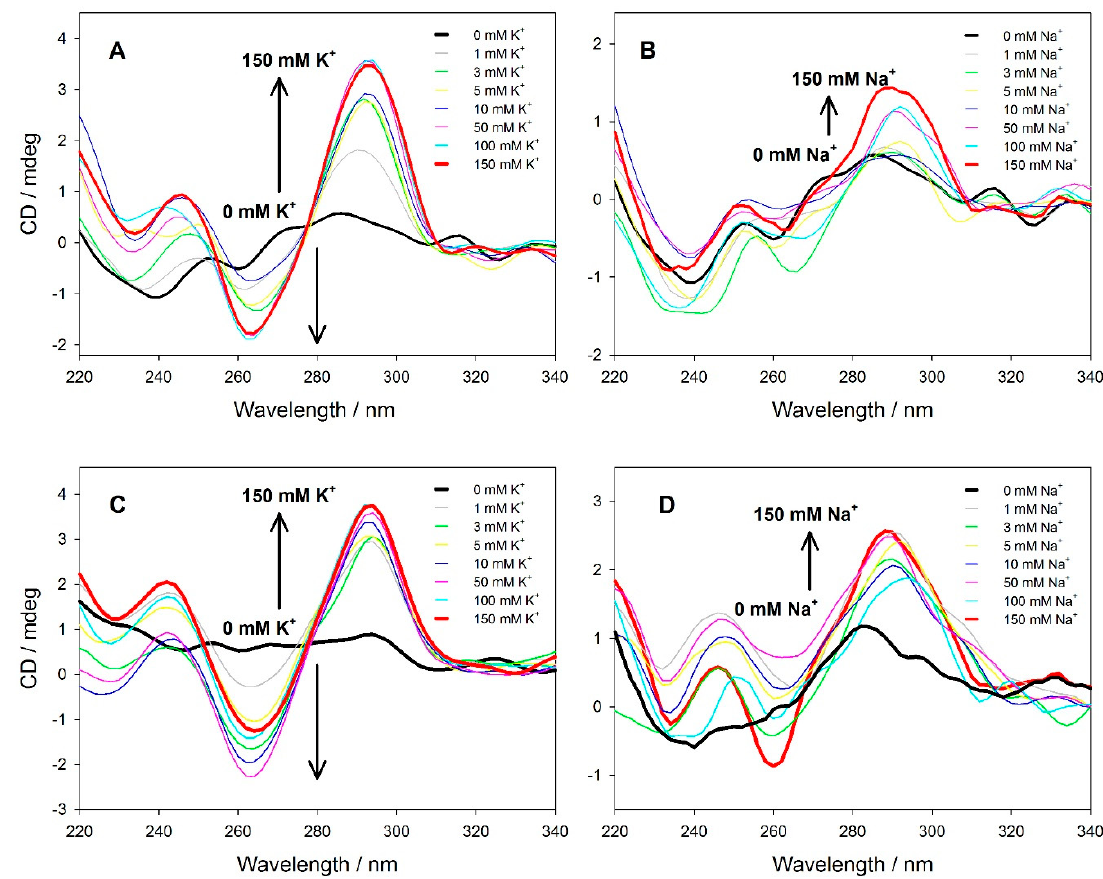
Figure 3. Effect of potassium and sodium ions on the CD spectra of 1 µ M Ch(F-TBA-T) ( A , B ) and Ch(py-TBA-py) ( C , D ) probes. Conditions: 10 mM TEA buffer (pH 7.5), KCl and NaCl concentration: 1, 3, 5, 10, 50, 100, 150 mM.